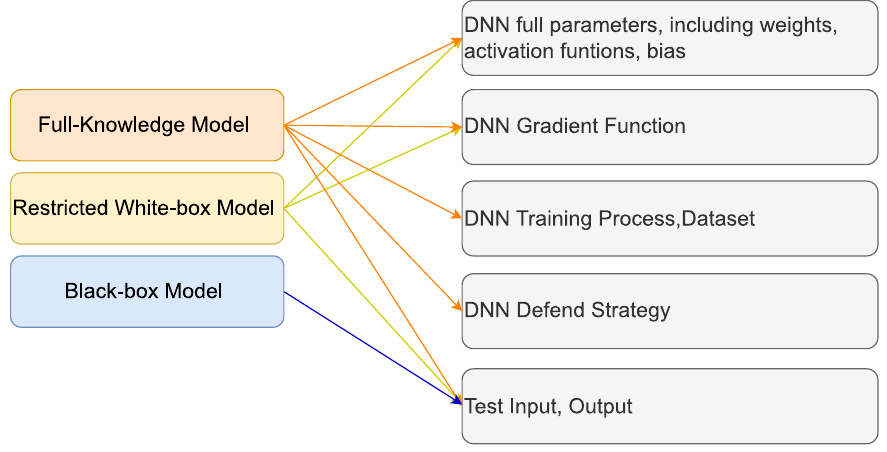
Figure 8. Different access permission to DNN sources for different threat